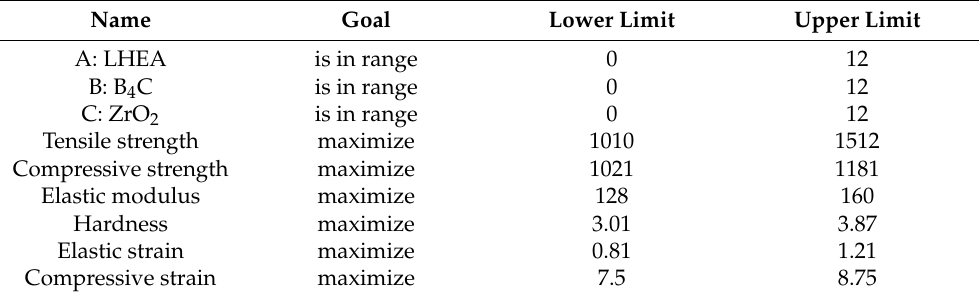
Table 5. Objectives for optimization and minimum and maximum response limitations.